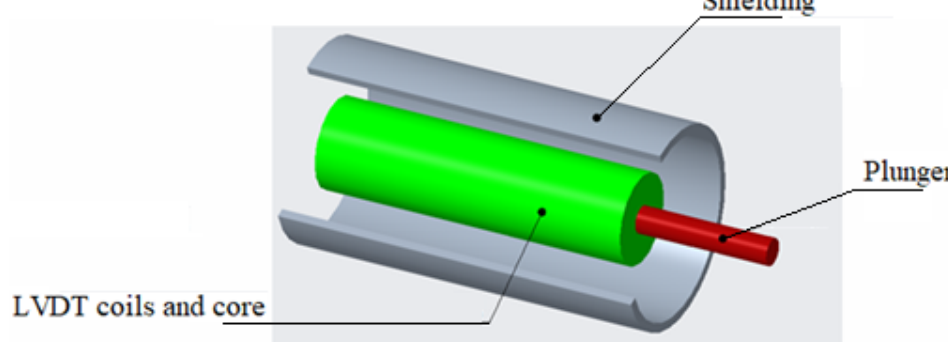
Figure 16. Shieling material around the LVDT.